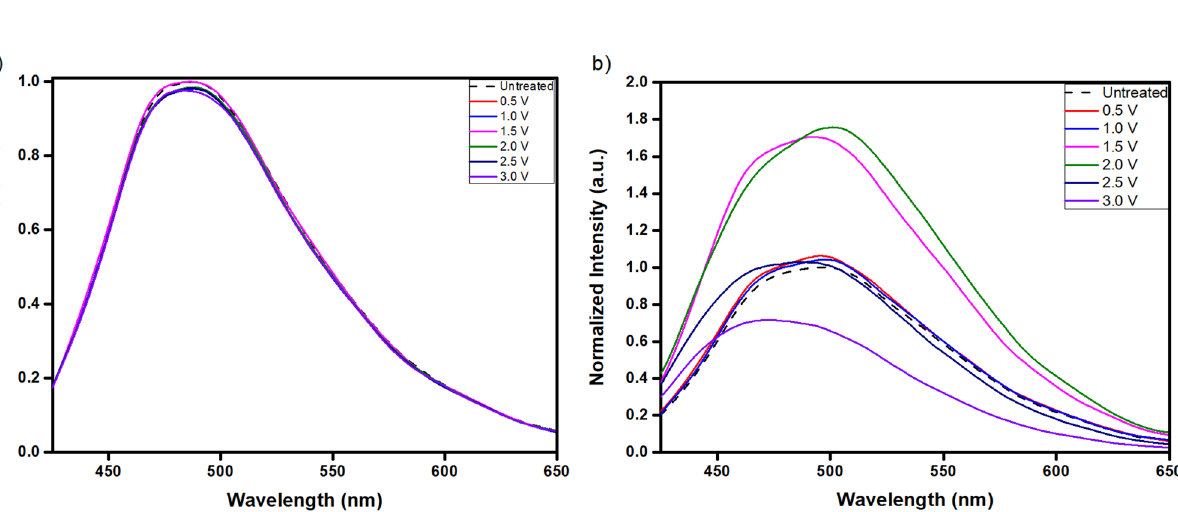
Figure 1. Normalized (against I max of the untreated dispersion) PL spectra (λ ex = 410 nm) of 0.02 mg ml –1 C-dots dispersed in 0.15 M aqueous solutions of ( a ) Na 2 CO 3 and ( b ) KCl that have been subjected to chronoamperometry treatment for 60 s at applied voltage from 0.5 to 3.0